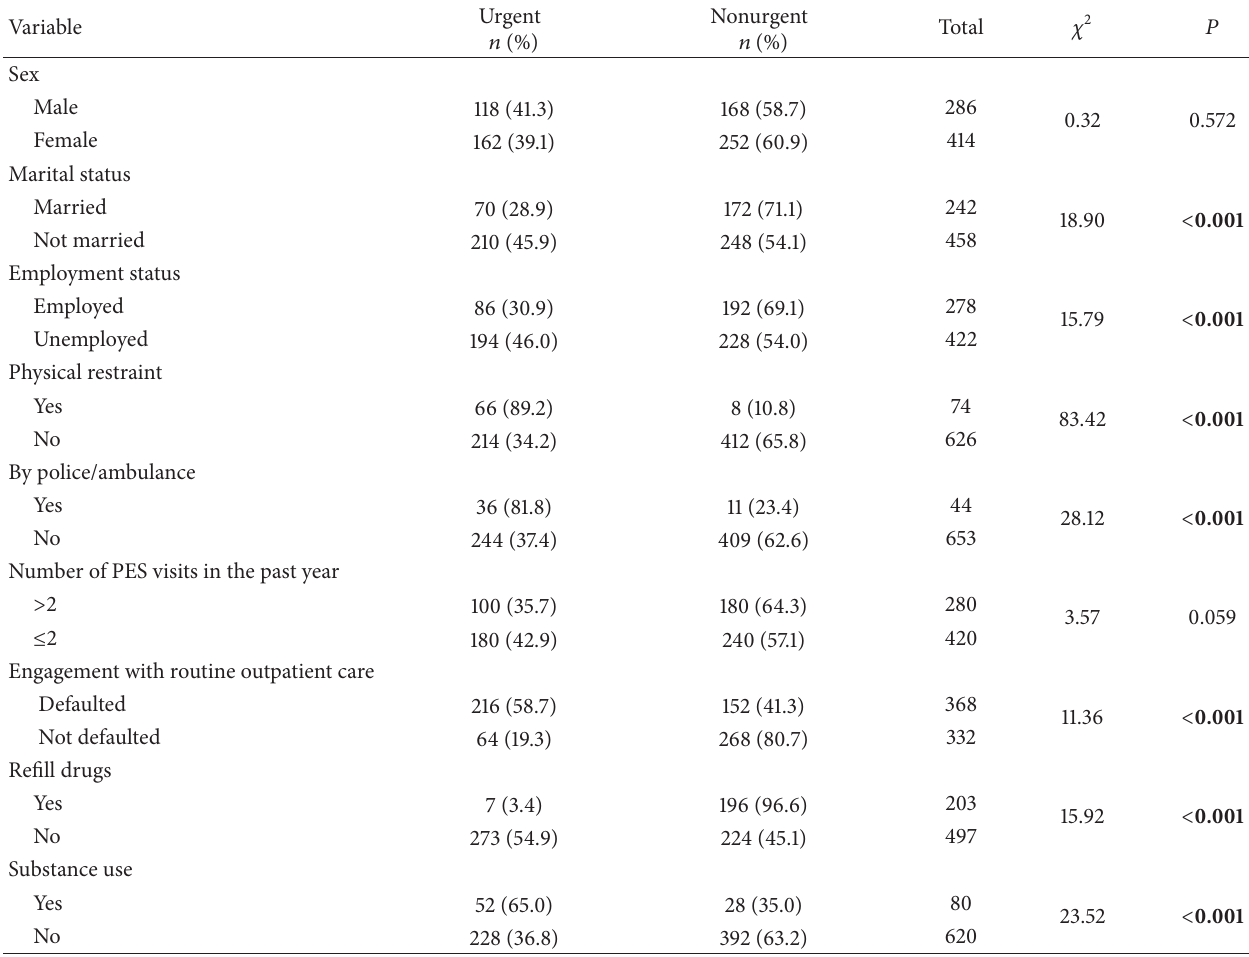
Table 4: Factors associated with urgency of presentations.